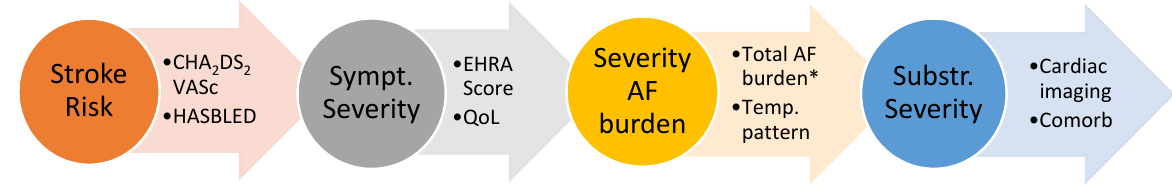
Figure 1. Structured characterization of AF: the newly introduced “4S-AF scheme” of the ESC Guidelines 2020 incorporates four domains to assess the individual disease state of the patient and highlights areas with essential therapeutic and prognostic implications. For a detailed explanation, see text. *Total AF burden = total time in AF per monitoring period or the longest episode or number of episodes.